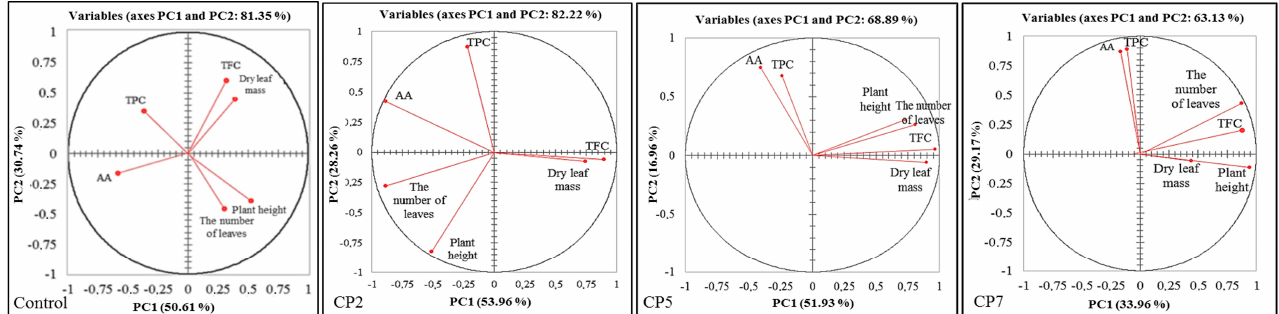
Figure 6. The correlation circles of the morphometric parameters (dry leaf mass, the number of leaves, plant height) and biochemical parameters (total phenolic content (TPC), total flavonoid content (TFC), antioxidant activity (AA) in stevia leaves) of the control group and treatment groups (CP2, CP5, and CP7).